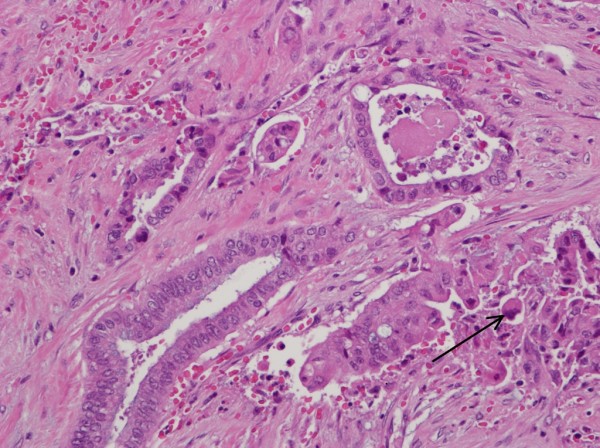
Higher magnification of the tumor shows tumor glands lined by cells with abundant eosinophilic cytoplasm with enlarged, hyperchromatic nuclei. While most of the tumor was a grade 2 adenocarcinoma, foci of single atypical cells (see arrow) infiltrating the pancreatic parenchyma, consistent with a poorly differentiated component, was also present.